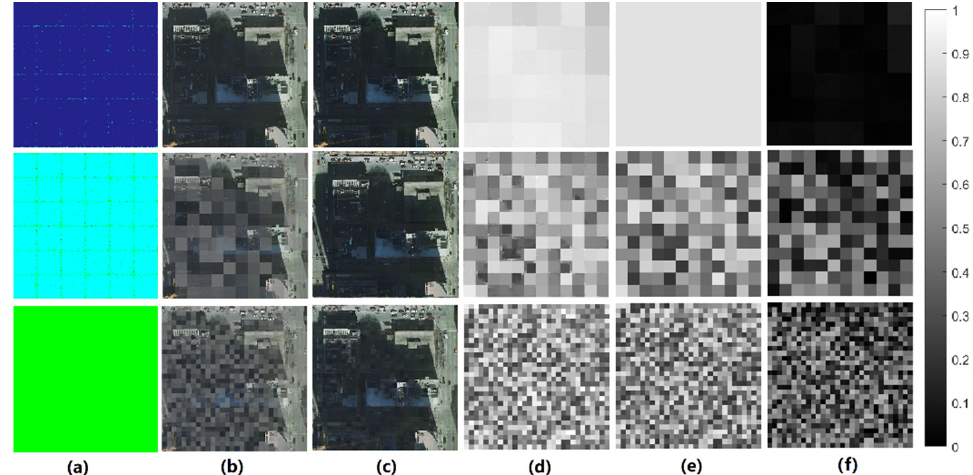
Figure 5. One-step DRL_Dehaze results for different haze scales in a city area. The first row presents the uniform-haze situation, the second row presents the medium-scale haze situation, and the last row presents the small-scale haze situation. ( a ) Action maps of the hazy aerial images, ( b ) hazy aerial images, ( c ) dehazed clear images of ( b ), ( d ) predicted atmosphere transmission maps, ( e ) ground truth values of the atmosphere transmission maps, and ( f ) differences in the predicted and true atmosphere transmissions. The bar on the right provides reference values for ( d )–( f ).